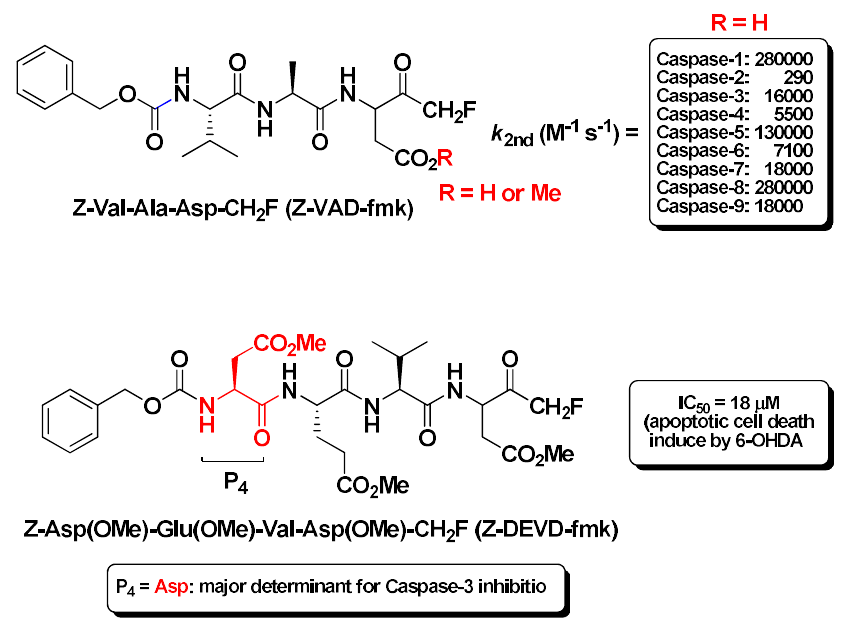
Figure 5. Chemical structure and some relevant biological data of the most representative tripeptidyl m-FMK (i.e., Z-VAD-fmk) and tetrapeptidyl m-FMK (i.e., Z-DEVD-fmk).